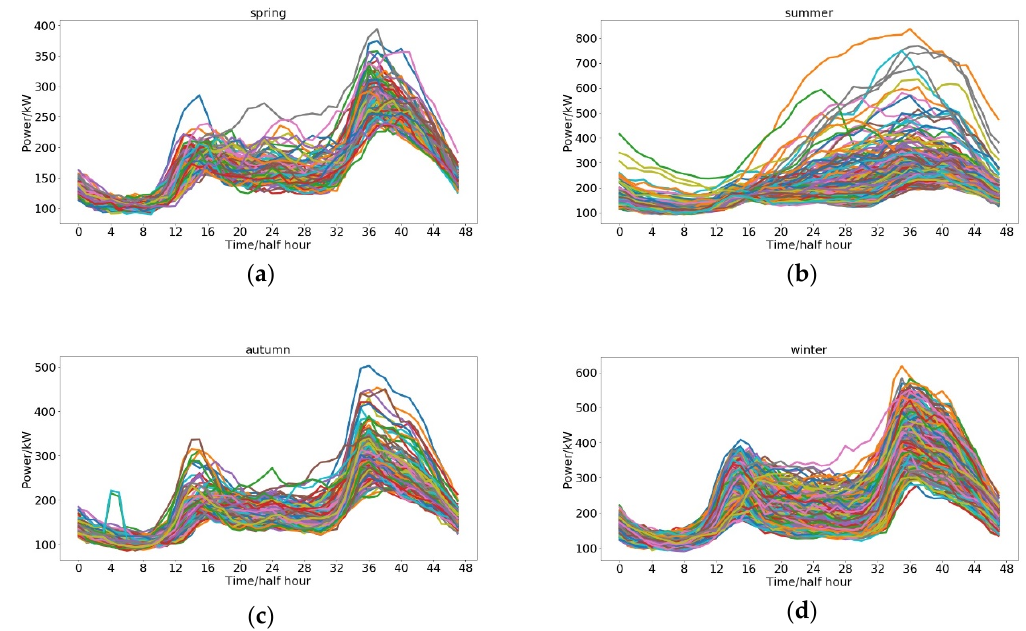
Figure 4. Clusters of actual load curves of ( a ) spring, ( b ) summer, ( c ) autumn and ( d ) winter.